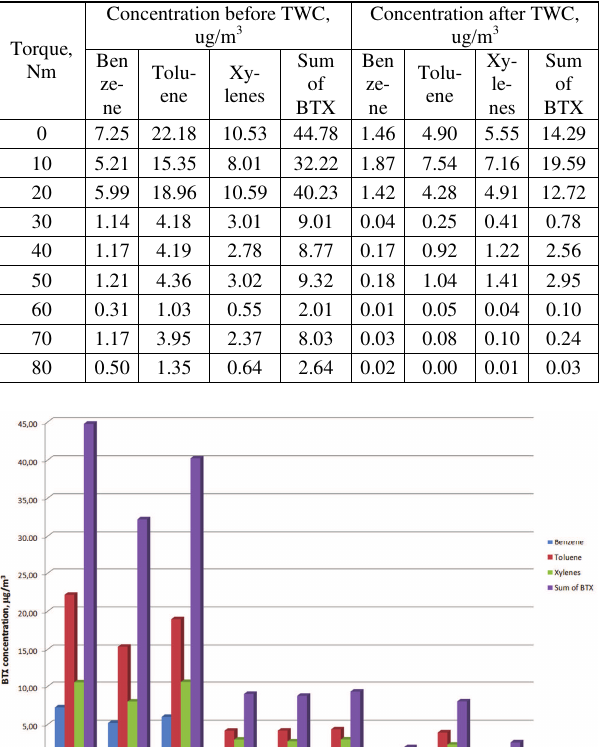
Fig. 5. Concentrations of benzene ( m g/m 3 ) depending on the torque value before and after three-way catalyst reactor In next step the efficiency of the three-way catalyst re-